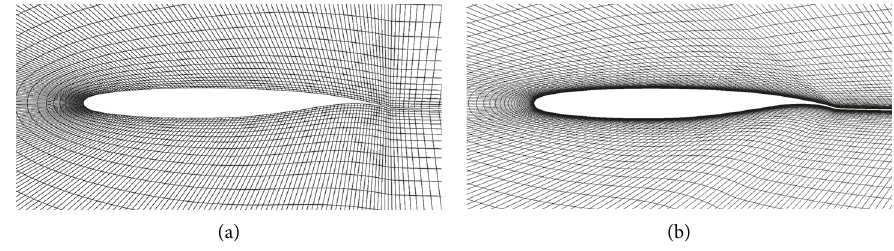
Figure 6: Closeup of initial algebraic meshes. (a) Euler mesh. (b) Navier–Stokes mesh.